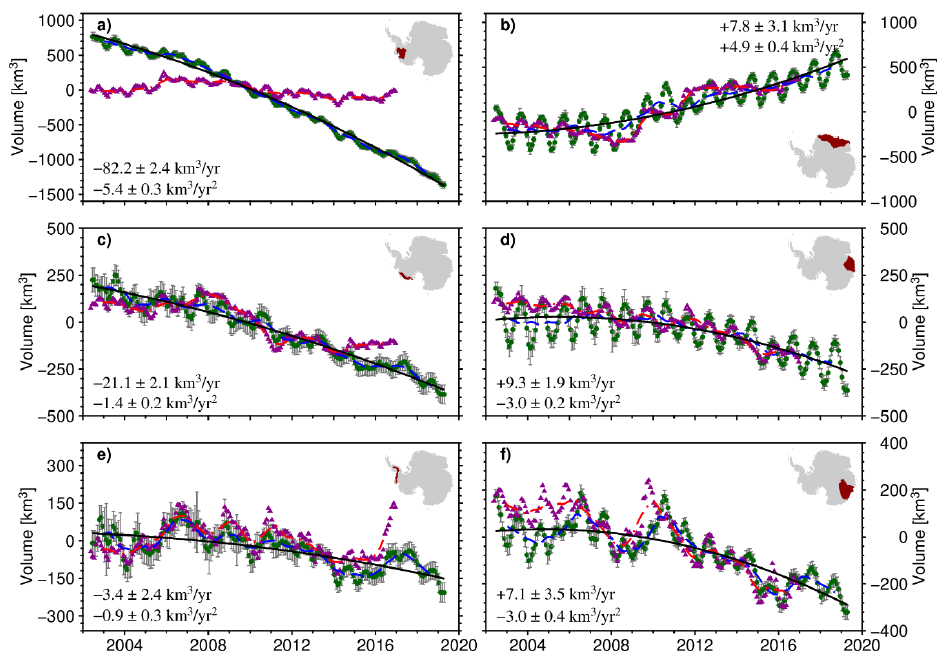
Figure 5. Volume change of some subregions north of 81.5° S (Amundsen Sea sector ( a ), Dronning Maud Land ( b ), Getz sector ( c ), Princess Elizabeth Land ( d ), Bellingshausen Sea sector ( e ), and Totten Glacier sector ( f )) from our combined altimetric time series (green dots) and the Institute for Marine and Atmospheric Research Firn Densification Model (IMAU-FDM) (purple triangles). The blue dashed curves and red dash-dotted curves are the time series after removing the seasonal oscillations using a 13-month moving average. Due to the defects of the moving average algorithm, the 6-month values at the beginning and end of the time series are not displayed. The solid black lines are the best-fit quadratic curves for the altimetric volume time series. Additionally, the altimetric volume time series’ linear and quadratic trend estimates are also included. The gray error bars show the 1σ uncertainty range of the altimetry data. The regions covered by each localization are shaded red in the inset. The boundaries refer to the Antarctic drainage systems in [47] .